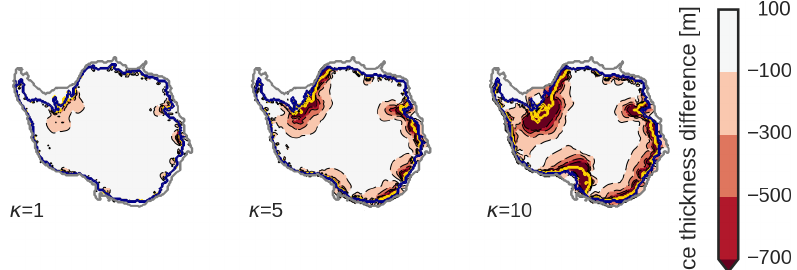
Figure 6. Ice thickness difference between the AIM and the cold phase (AIM minus cold) for different values of oceanic sensitivity ( κ = 1, 5, and 10ma − 1 K − 1 ). Zones with an intense red color illustrate a larger ice difference and hence a major ice loss. The thick blue line illustrates the grounding line position at the cold phase and the thick yellow line the grounding line position at the AIM phase. The thick grey line illustrates the position of the continental shelf